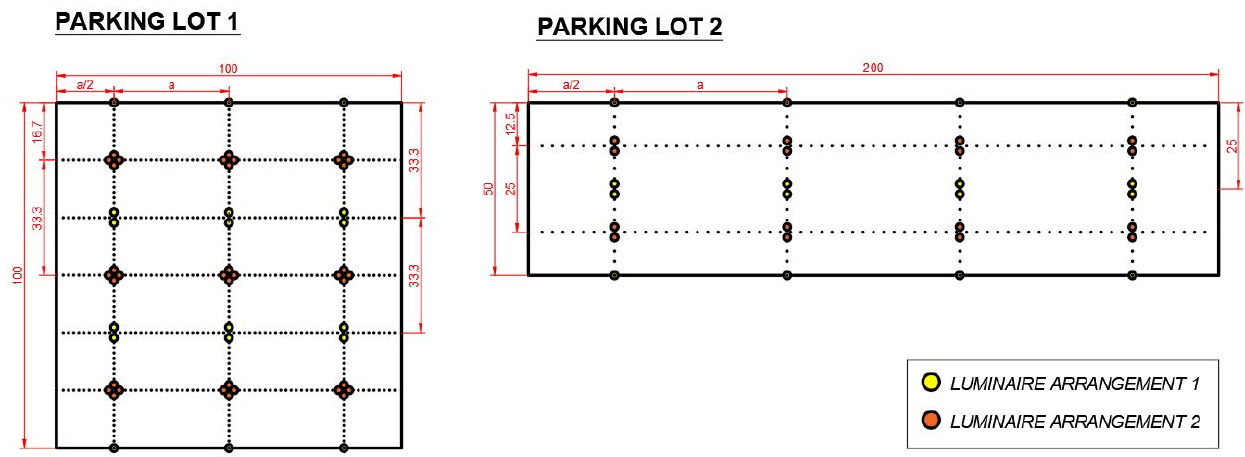
Figure 3. Schematic layout of poles on the area of analyzed parking lots. Calculations of the luminous environment parameters were made following the Euro- pean standard for outdoor lighting [56]. The dimension of the calculation grid is 4 m, and the calculation points have been evenly distributed over the area of both parking lots. In total, 432 lighting solutions were obtained for which all the previously discussed parame- ters of the luminous environment, light pollution, and energy efficiency were calculated. By analyzing such many cases and variables, it is possible to determine the relationship between the parameters of light pollution and energy efficiency. However, it should be noted that for significant changes in the assumptions (e.g., emission also into the upper hemisphere or other reflectance values of the task field and the surroundings), the obtained results will be different. Nevertheless, simulation studies identify the most typical solutions and everyday lighting situations. Then, the obtained results were compared, presenting histograms of the relevant parameters. Finally, we decided to investigate whether there is a linear correlation between the UFR parameter and the utilance and the normalized power density, and if so, what level it